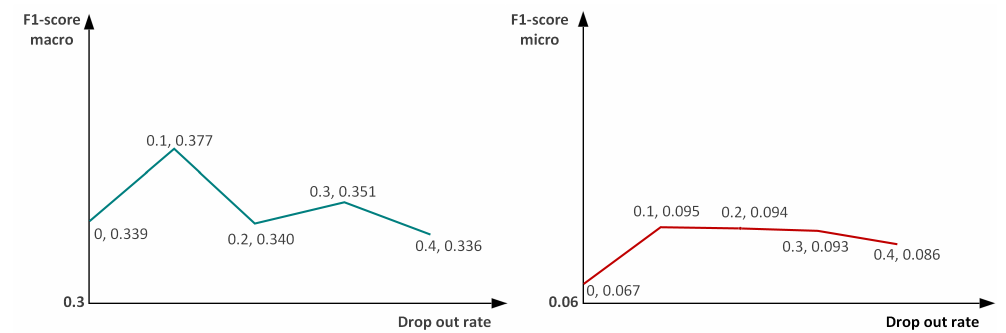
Figure 9. Exploration of dropout rate. The left graph shows the curves of macro-expression indicators, and the right graph shows the curves of micro-expression indicators.